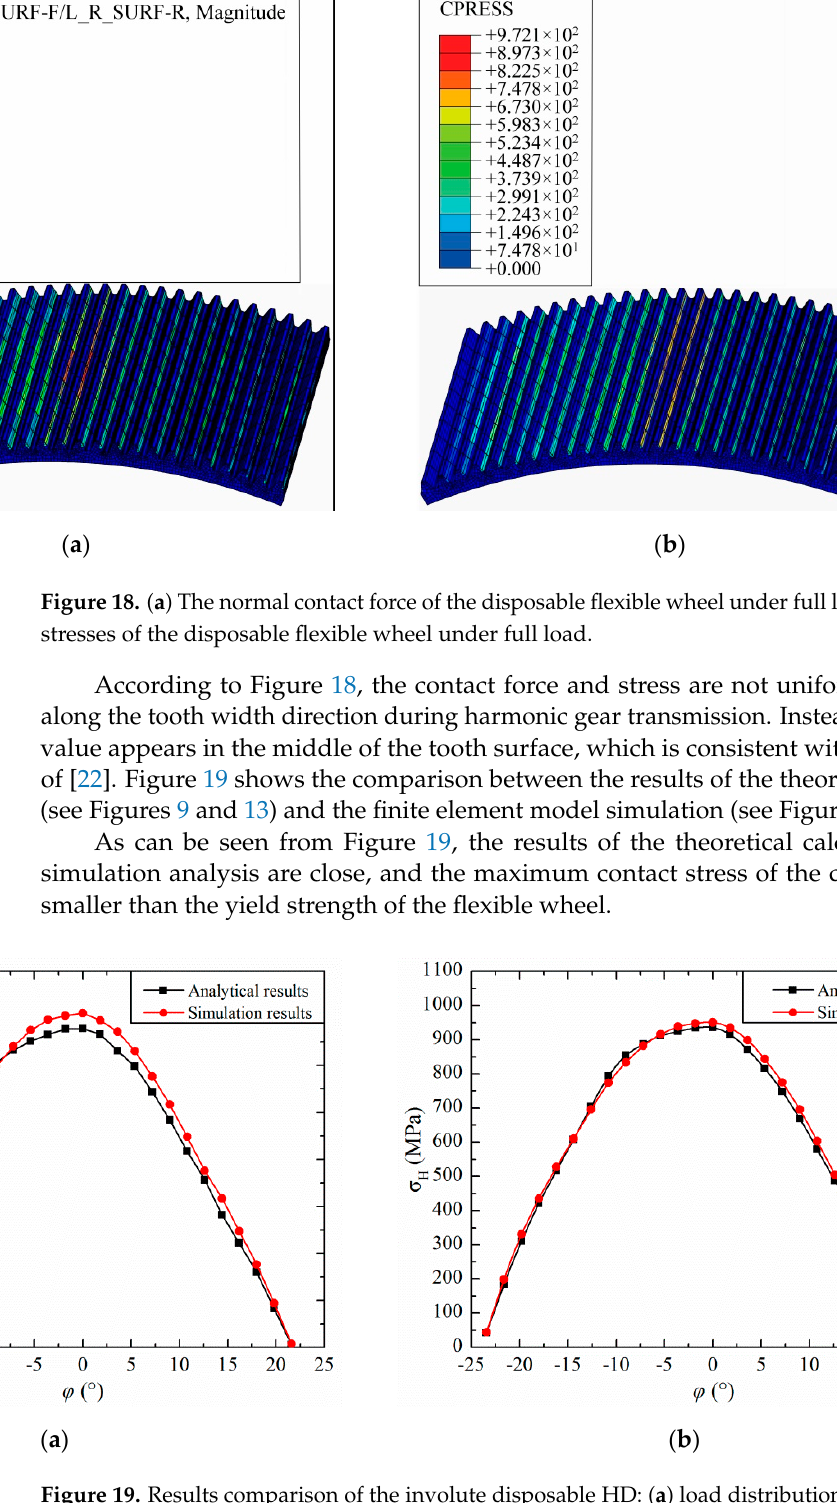
Figure 17. Meshing contact diagram of partial tooth pairs during transmission.